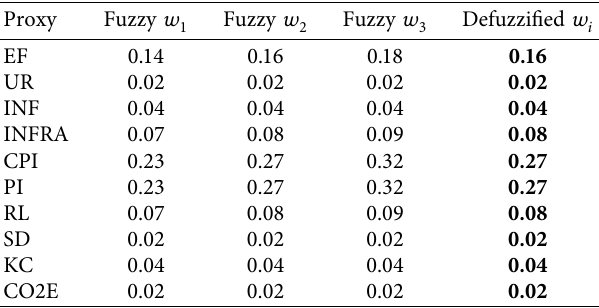
Table 13: Fuzzy weights and their respective proxies.